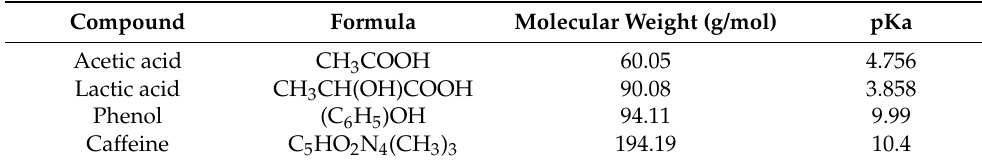
Table 1. Properties of compounds used for the permeation test [31].